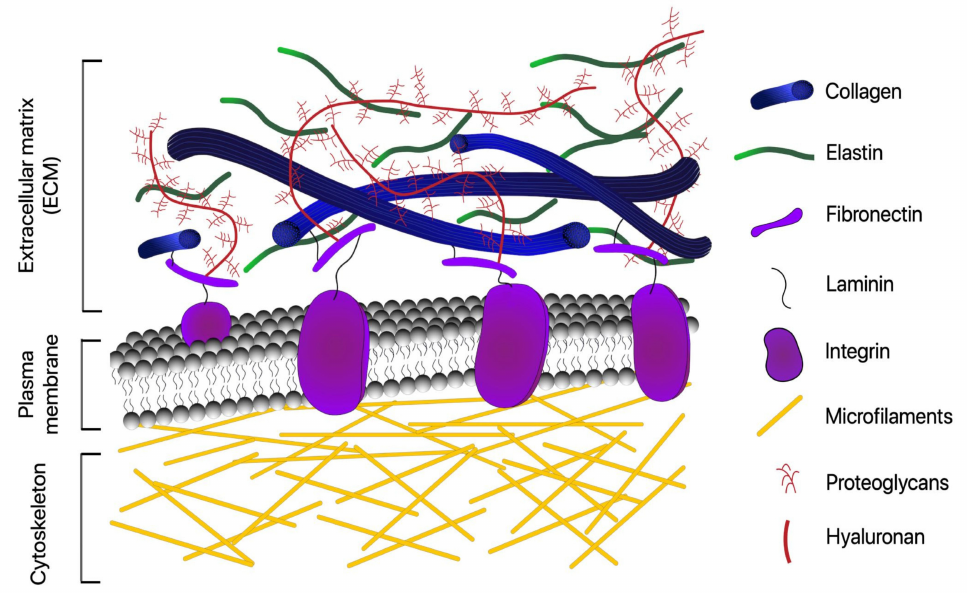
Figure 1. Schematic overview of extracellular matrix and its major components. Although the ECM composition varies depending on the tissue, the matrix is mainly composed of a variety of fibrous proteins (collagen, elastin, fibronectin, and laminin) and polysaccharides that are secreted locally and assembled into an organized meshwork in close association with the surface of the cell that produced